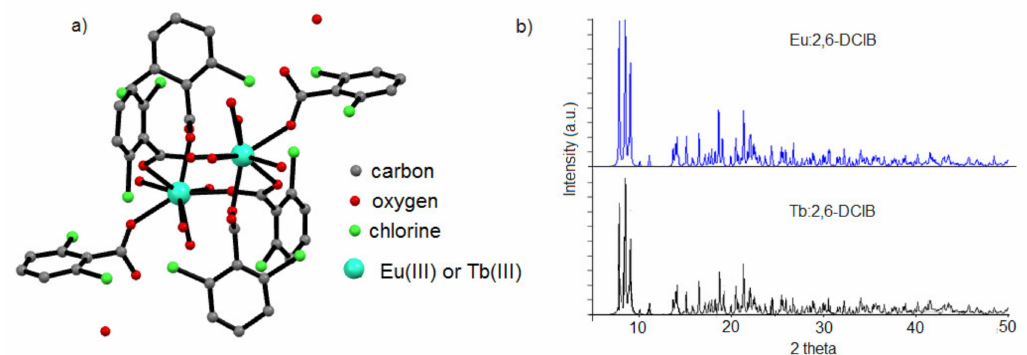
Figure 1. ( a ) Structural characterization of the dopants: europium(III) and terbium(III) complexes with 2,6-dichlorobenzoic acid (hydrogen atoms were omitted for figure clarity); ( b ) XRD patterns of lanthanide